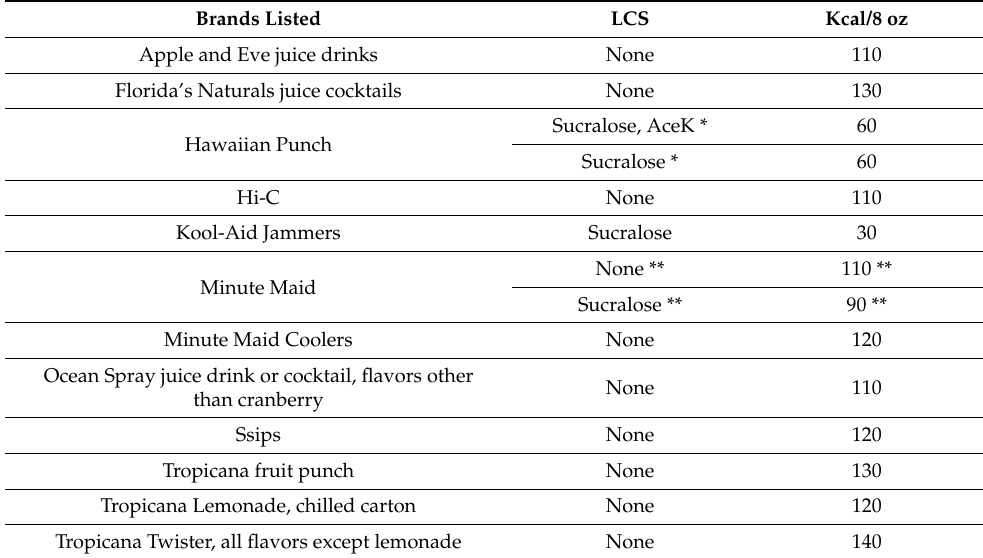
Table 3. Branded beverages listed in the description of FNDDS Foodcode 92530610 (114 kcal/8 oz) “Fruit juice drink, with high Vitamin C”